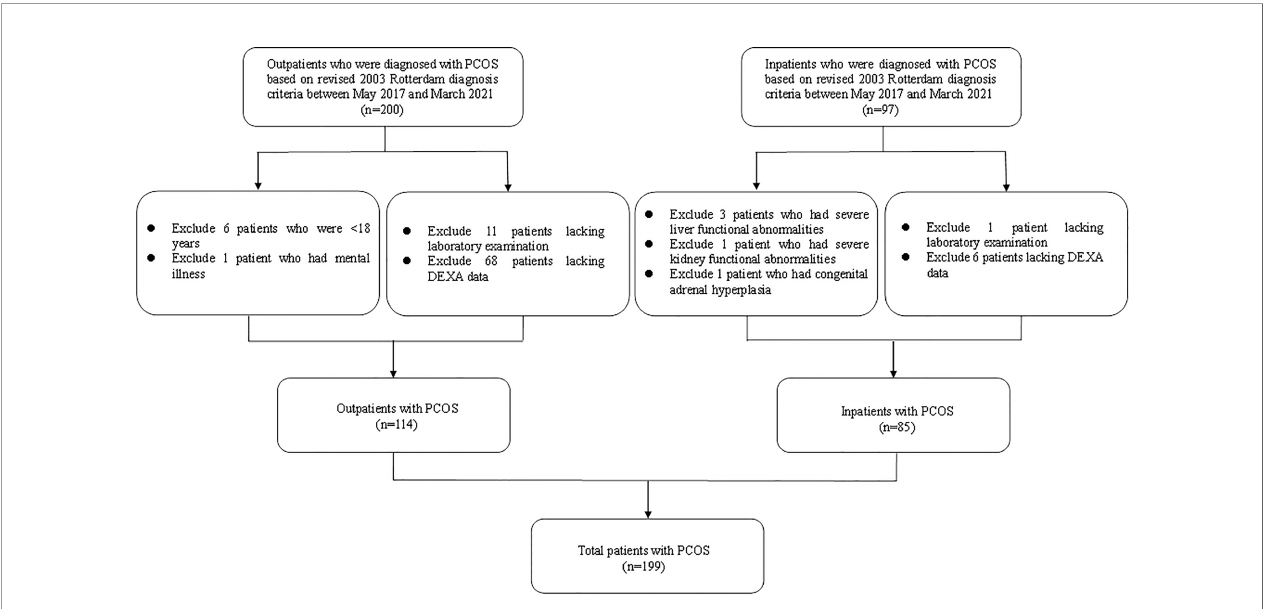
FIGURE 1 | Flow diagram of the population included in the